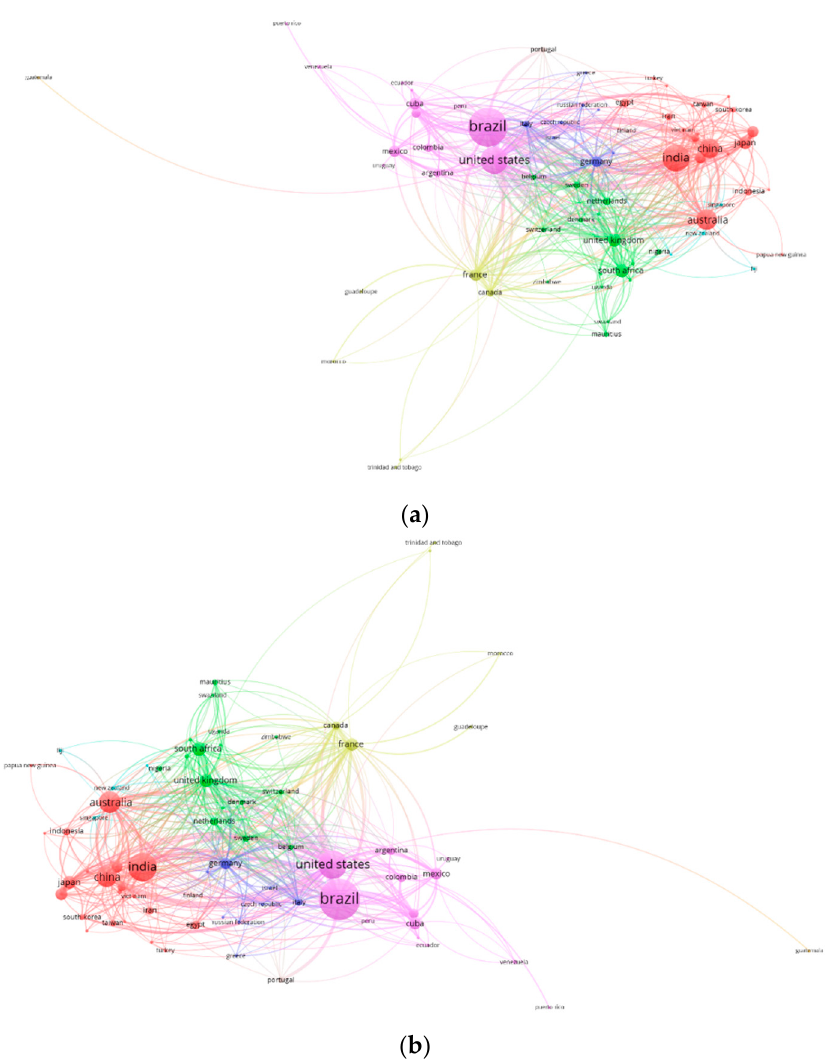
Figure 3. International country co-authorship network of publications related to sugarcane research. ( a ) By number of documents. ( b ) By number of citations.